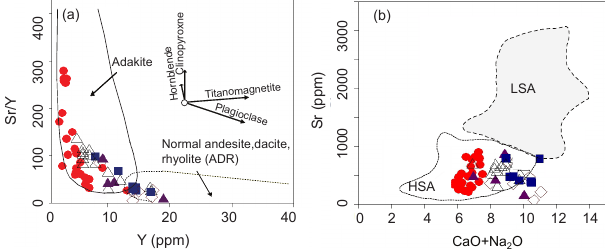
Figure 8. (a) Plot of Sr / Y vs. Y for the studied rocks. Fields of adakite and arc-normal rocks are from Petford and Ather- ton (1996) and Defant and Drummond (1990). (b) Plot of Sr vs. CaO + Na 2 O (wt%) showing the chemical differences between low silica adakites (dashed field) and high-silica adakites (dotted field) (after Castillo, 2012).